Question: Give a one-sentence summary of this figure.
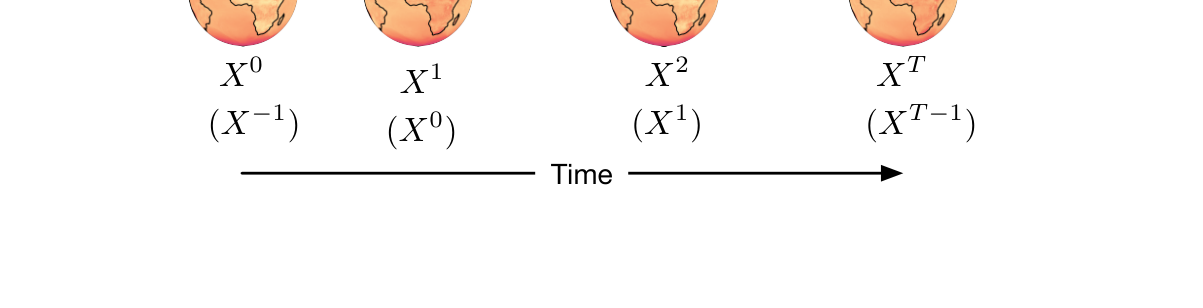
Answer: | Schematic of how GenCast produces a forecast. The blue box shows how conditioning inputs, (𝑋0, 𝑋−1), and an initial noise sample, 𝑍1 0, are refined by the neural network refinement function, 𝑟𝜃(green box), which is parameterised by 𝜃. The resulting 𝑍1 1 is the first refined candidate state, and this process repeats 𝑁times. The final 𝑍1 𝑁is then added as a residual to 𝑋0, to produce the weather state at the next time step, 𝑋1. This process then repeats, autoregressively, 𝑇= 30 times, conditioning on (𝑋𝑡, 𝑋𝑡−1) and using a new initial noise sample 𝑍𝑡 0 at each step, to produce the full weather trajectory sample (for visual clarity, we illustrate the previous state in parentheses, (𝑋𝑡−1), below the current state, 𝑋𝑡). Each trajectory generated via independent 𝑍1:𝑇 0 noise samples represents a sample from, 𝑝 𝑋1:𝑇|𝑋0, 𝑋−1.